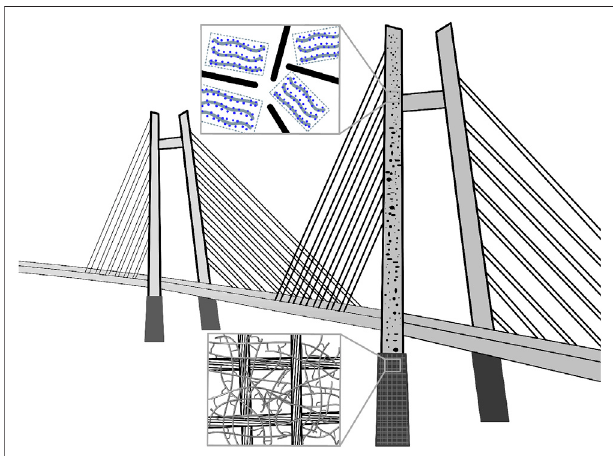
FIGURE 1 | Applicationsof fi